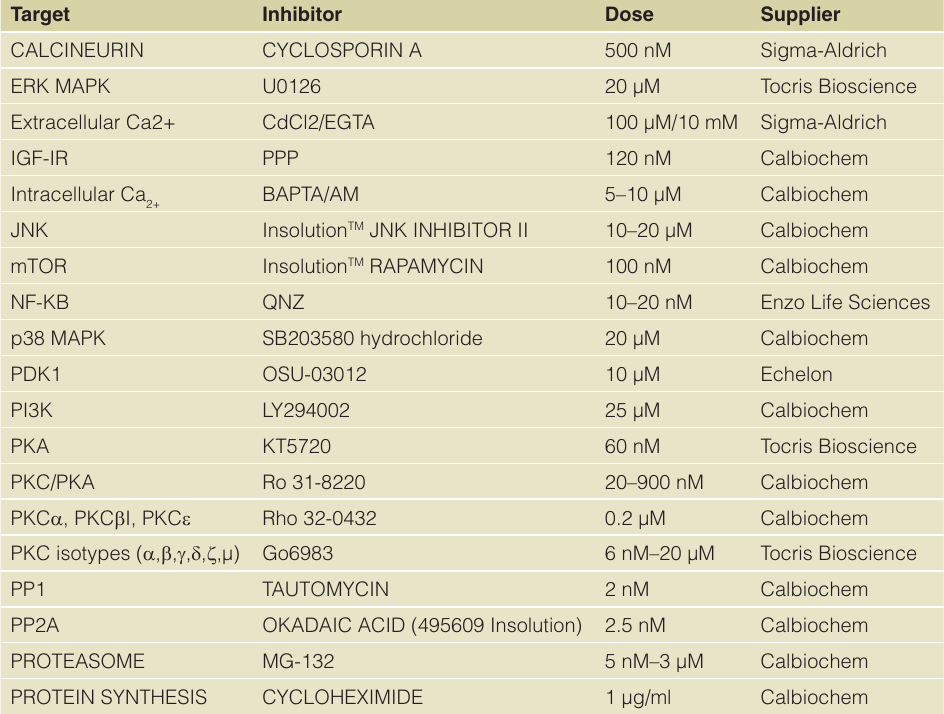
Table 2. Drug inhibitors used in the